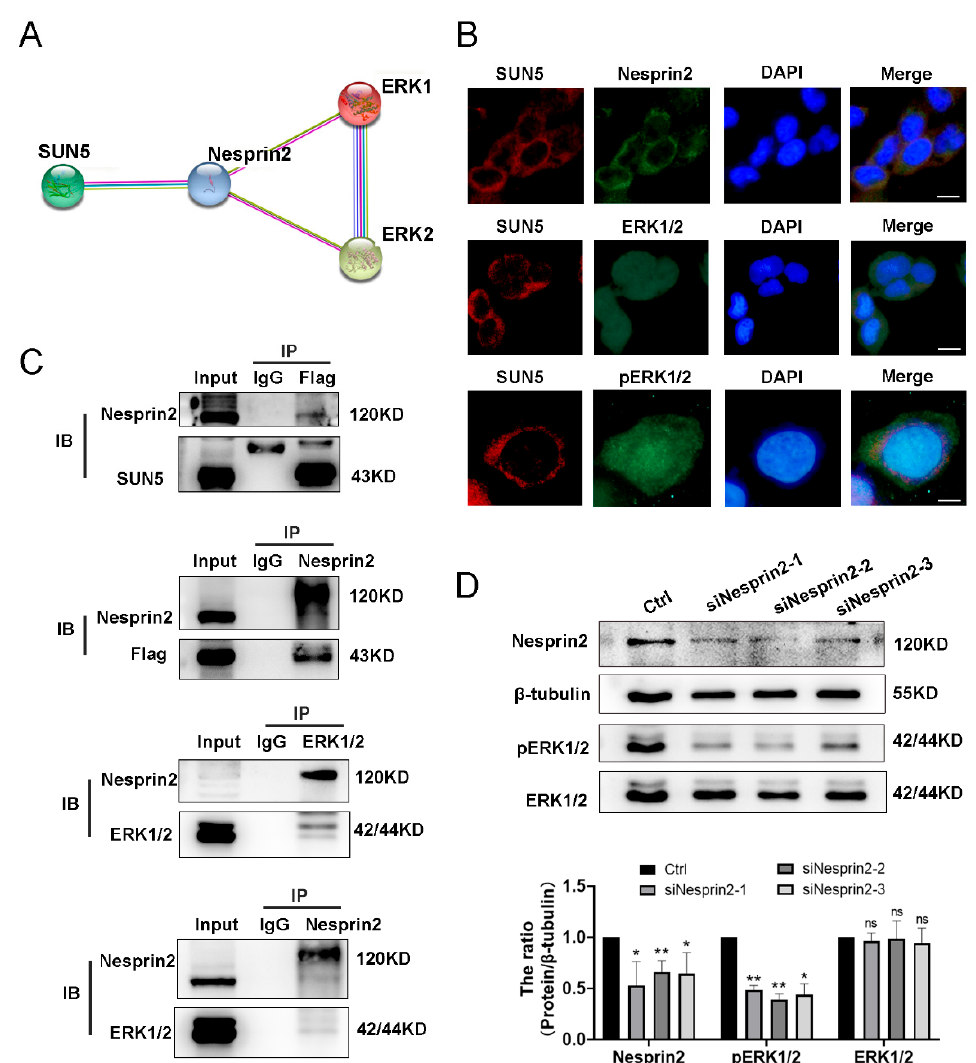
Figure 7. SUN5 cooperated with Nesprin2 to regulate the ERK pathway. ( A ) Interaction network analysis of SUN5, Nesprin2, and ERK1/2 by the STRING database. ( B ) Immunofluorescence staining results showed the co-localization of SUN5 (red), Nesprin2 (green), and ERK1/2 (green) in DLD-1 cells. DAPI was used for nuclear staining (blue). Scale bar: 15 µ m, 15 µ m, and 5 µ m from top to bottom. ( C ) The interaction network of SUN5, Nesprin2, and ERK1/2 was validated by Co-IP analysis. ( D ) Western-blotting assay showed that Nesprin2 silencing decreased the level of pERK1/2 in SUN5-OE cells. β -tubulin was used as an internal control (* p < 0.05, ** p < 0.01; “ns” indicates not significantly different).